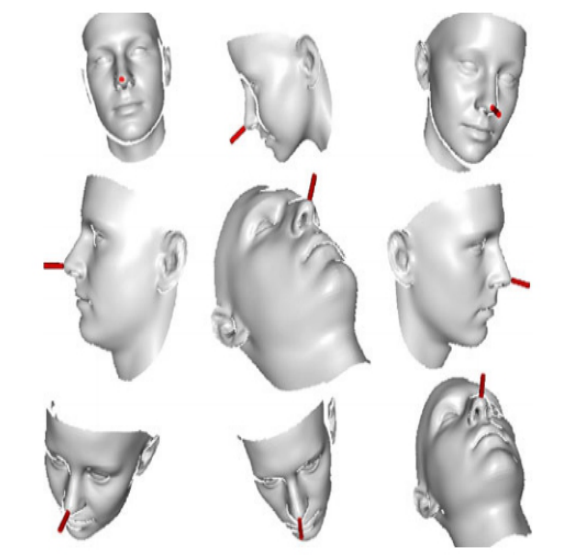
Figure 3. Ground truth data creation for HPE task using synthetic